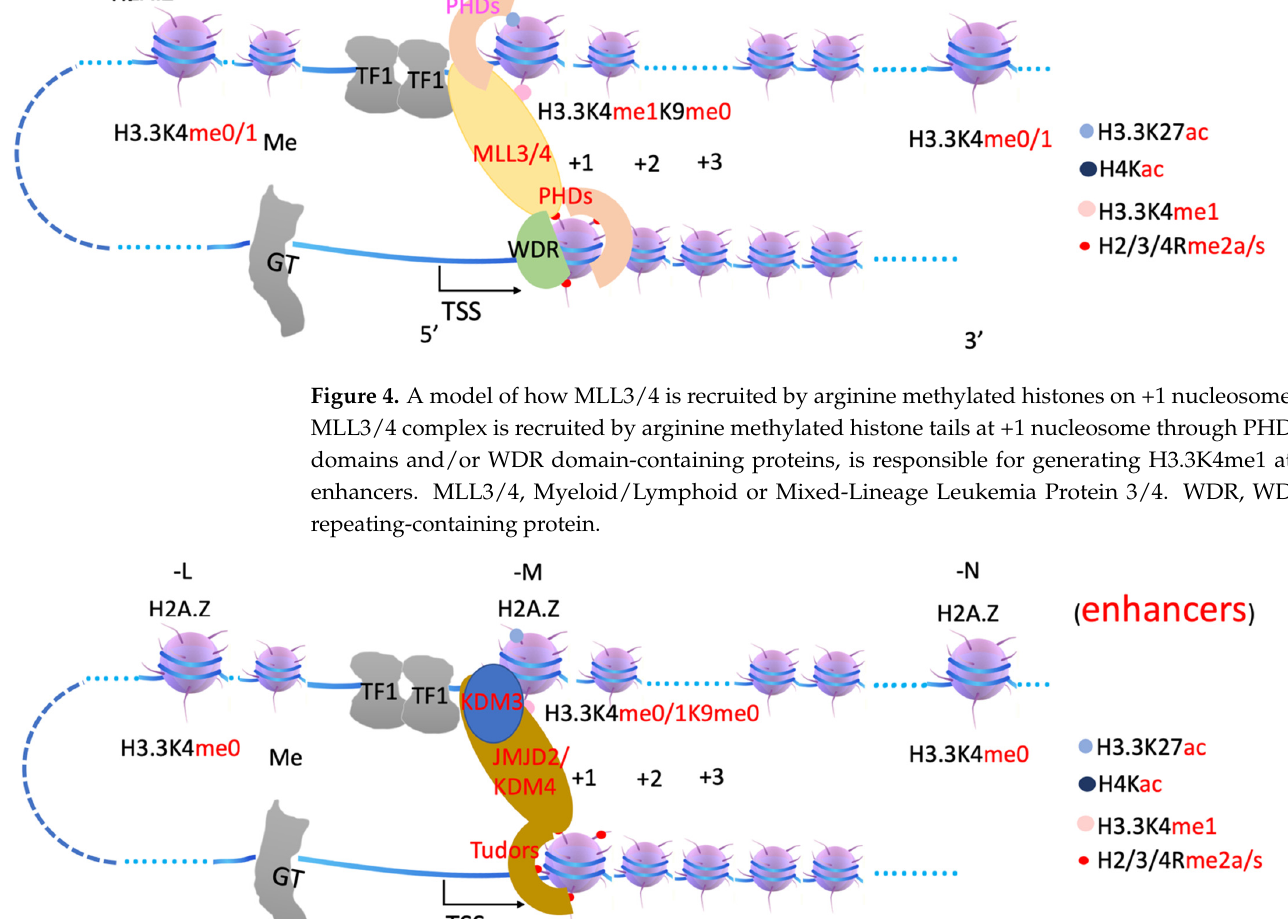
Figure 4. A model of how MLL3/4 is recruited by arginine methylated histones on +1 nucleosome. MLL3/4 complex is recruited by arginine methylated histone tails at +1 nucleosome through PHD domains and/or WDR domain-containing proteins, is responsible for generating H3.3K4me1 at en- hancers. MLL3/4, Myeloid/Lymphoid or Mixed-Lineage Leukemia Protein 3/4. WDR, WD repeat- ing-containing protein.